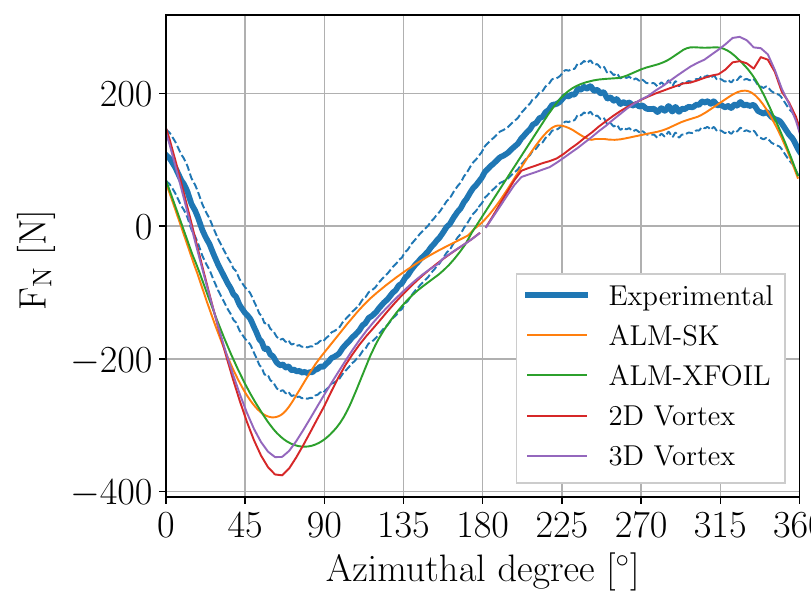
Figure 7. The normal force response at λ = 2.55.